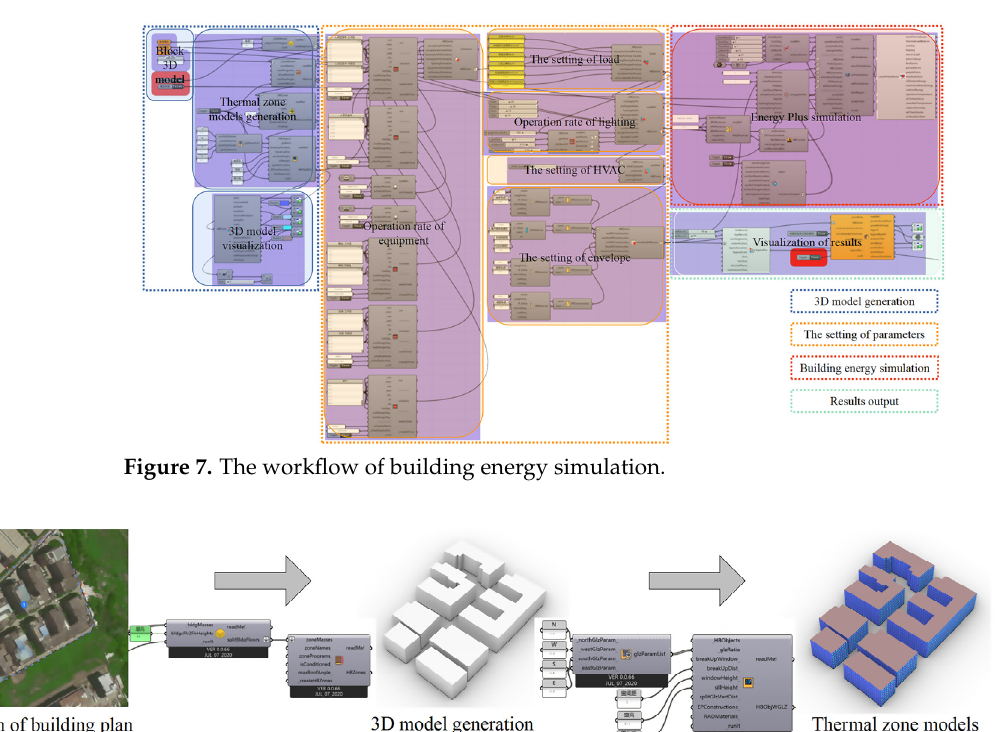
Figure 7. The workflow of building energy simulation.